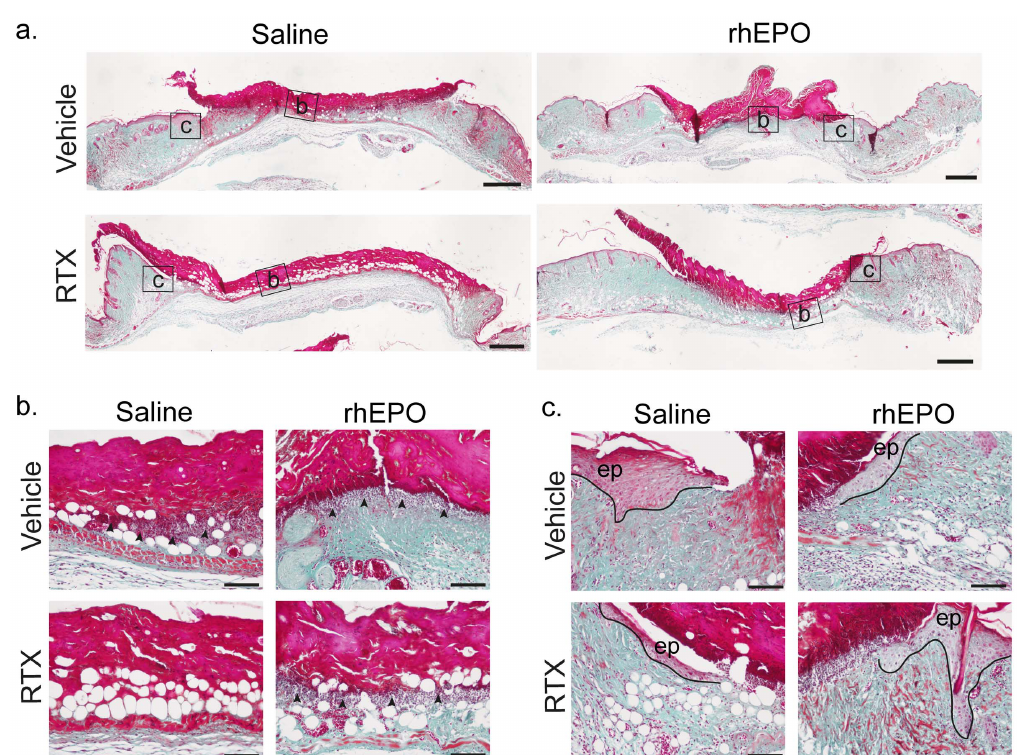
Figure 7. Effects of RTX and rhEPO on cutaneous histological findings 72 h after pressure release. Ischemic skin lesions were removed 72 h after pressure release and stained with Masson’s trichrome. ( a ) Histological look of pressure ulcer (PU). Scale bar 5 500 m m. ( b, c ) Microphotographs taken from (a) of central compressed area (b) and of ischemic wound margins (c) Arrows indicate infiltrates of inflammatory cells. Scale bar 5 100 m m. ep: epidermis, rhEPO: recombinant human erythropoietin, RTX: